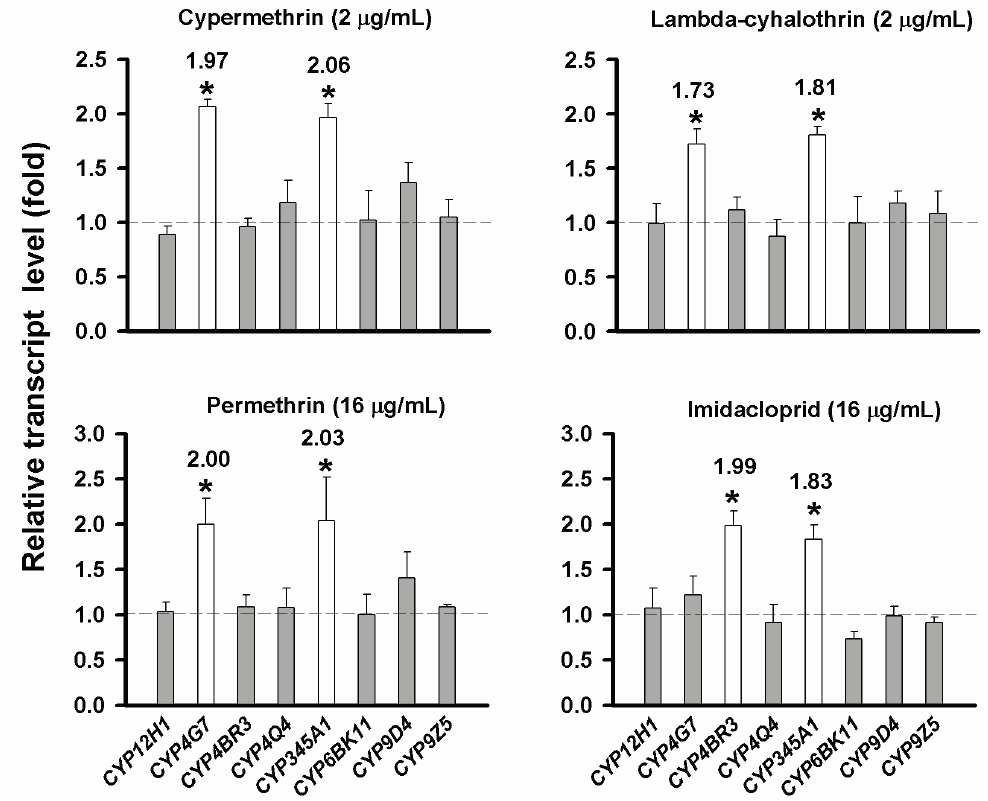
Figure 3. Up-regulation of CYP genes in T. castaneum after exposed to different insecticides. Dash lines represent relative transcript level of the control (larvae treated with the insecticide solvent only) as 1.0. The up-regulation fold was acquired by comparing the transcript levels of each CYP between the treated and the control insects. The CYP genes with a statistically significant up-regulation are marked with asterisks (Student’s t test, * p <